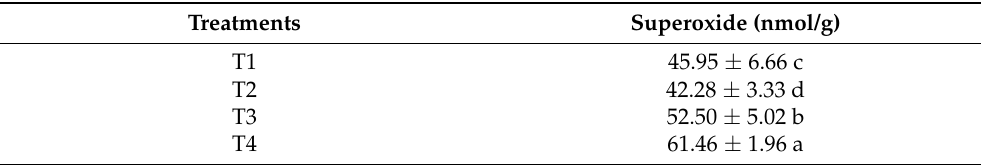
Table 5. Effects of endophytic B. bassiana on superoxide (mean ± SE nmol/g) content in tomato leaves following exposure to pathogenic